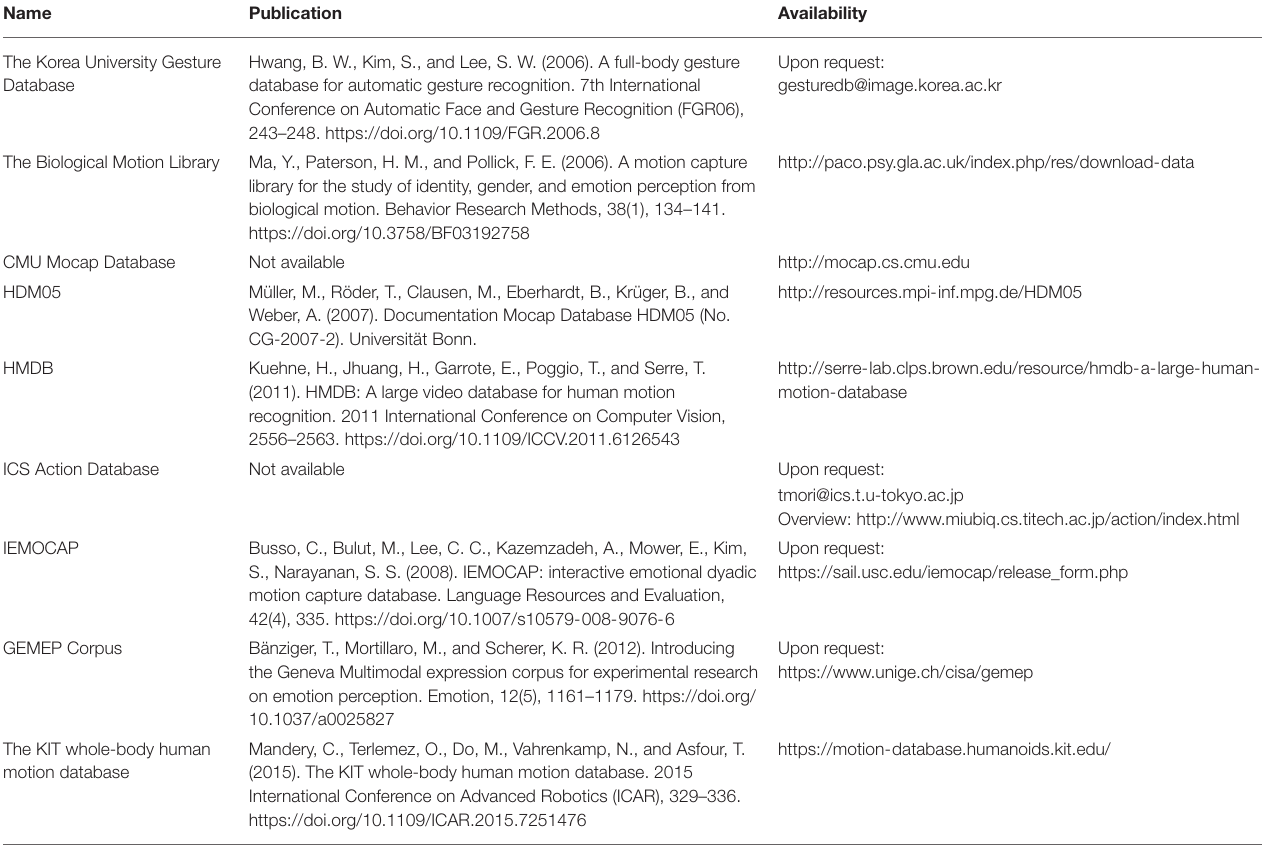
TABLE 2 | Existing motion capture databases.